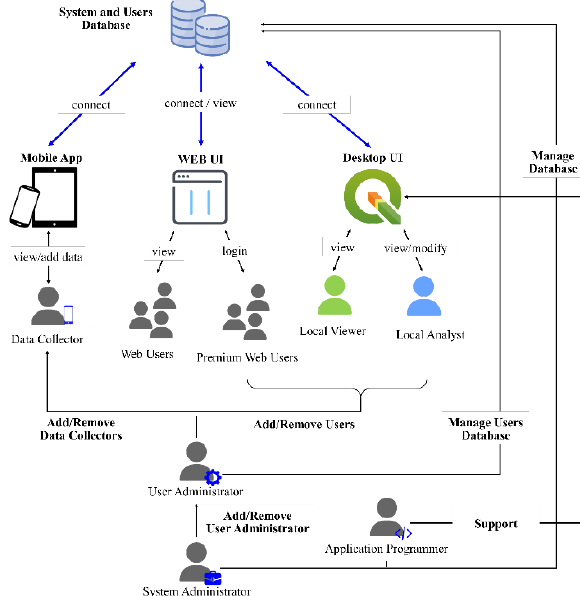
Figure 4. End-user categories of the